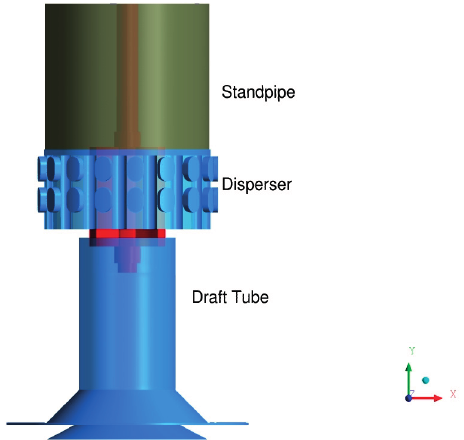
Figure 1. Core of the Wemco-0.8m 3 machine: rotor, disperser, draft tube, and standpipe.